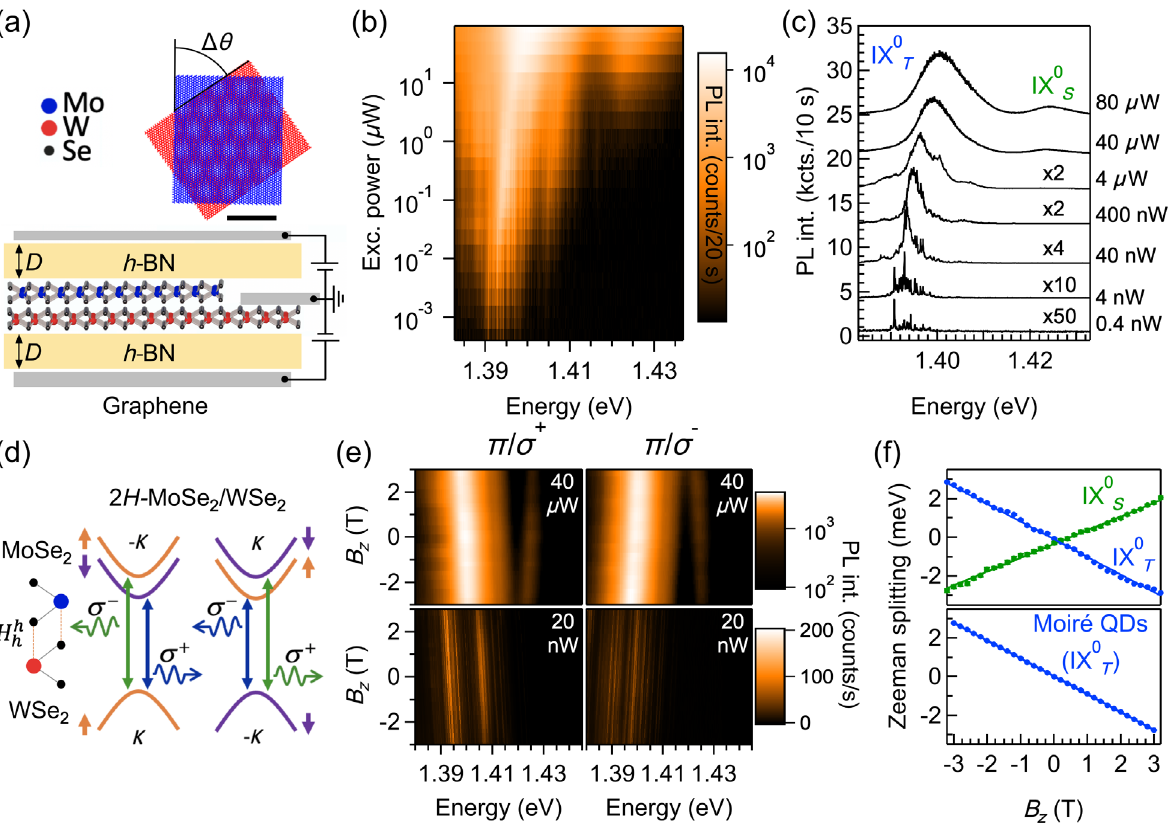
FIG. 1. Power dependence of moir´e-trapped IXs. (a) Sketch of the dual-gated WSe 2 = MoSe 2 heterobilayer. Graphite layers are used as contacts for top, bottom, and heterobilayer, while h -BN layers ( D ¼ 18 nm) are used as dielectric spacers. (b) Color plot with the full evolution of the low-temperature ( T ¼ 4 K) confocal PL spectrum of a representative spot in the undoped heterobilayer for 0 . 4 nW ≤ ≤ 80 μ W in logarithmic scale. (c) Line cuts extracted from the color plot in (b) for P P exc spectra are shifted vertically and normalized by the values indicated in the figure for visualization purposes. (d) Schematics of the spin- valley configuration of the proposed optical transitions with the corresponding selection rules for H h field dependence of IX PL in the low- and high-excitation regimes (bottom and top panels, respectively) for σ þ - and σ − -resolved confocal collection (left and right panels, respectively). (f) Magnetic field dependence of the Zeeman splitting measured for IX 0 at high P (top panel) and for a representative moir´e-trapped IX at low P exc